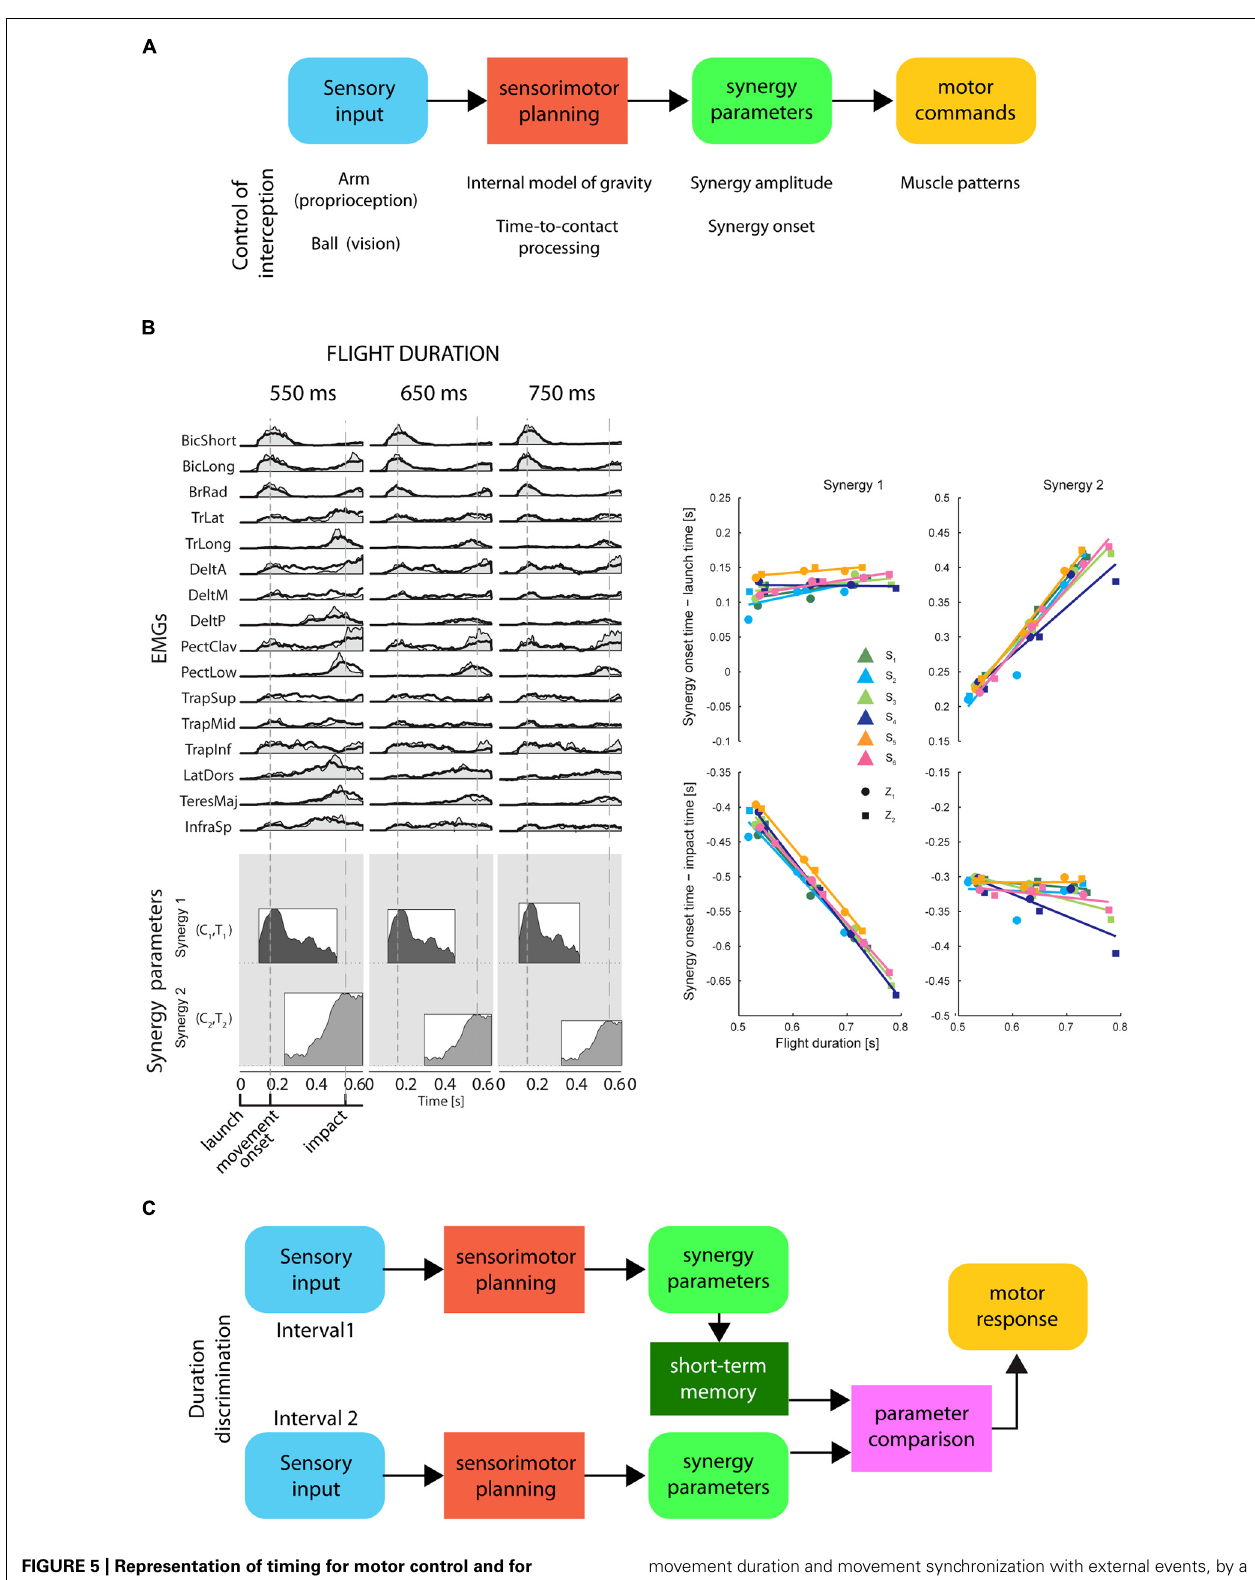
FIGURE 5 | Representation of timing for motor control and for perceptual discrimination by synergy parameters. (A) Conceptual scheme of the information processing stages for the control of motor timing, i.e.,